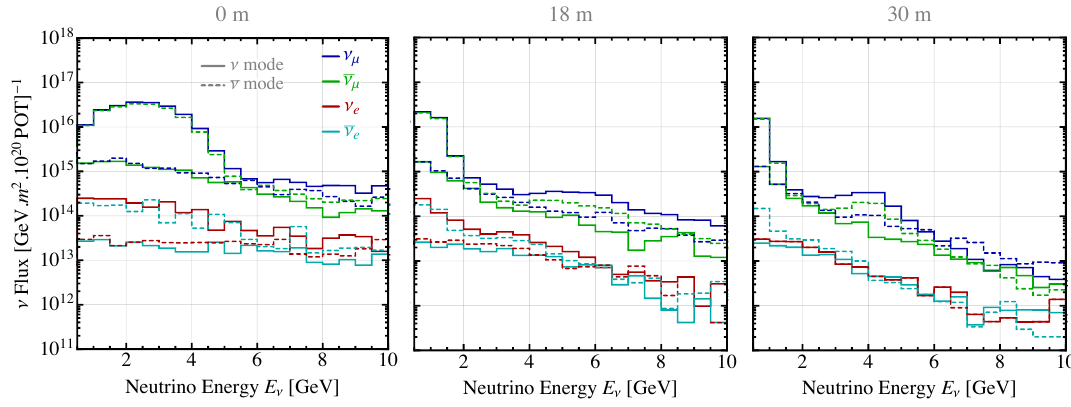
Figure 1 . The neutrino fluxes in the on-axis and two off-axis positions we have considered in this work, based on [11]. For each neutrino (solid) or anti-neutrino (dashed) modes we have shown the fluxes for ν µ (blue), ¯ ν µ (green), ν e (red) and ¯ ν e